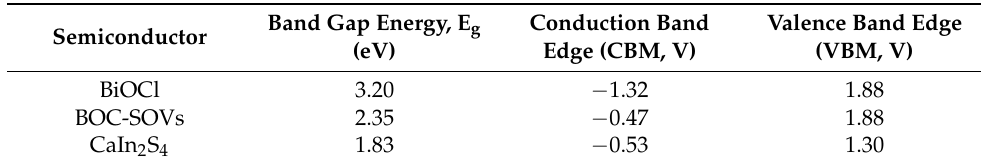
Figure 13. ( a , b ) The corresponding Tauc curves of BiOCl, BOC-SOVs, and CaIn 2 S 4 , and ( c , d ) VB spectra of the BOC-SOVs and CaIn 2 S 4